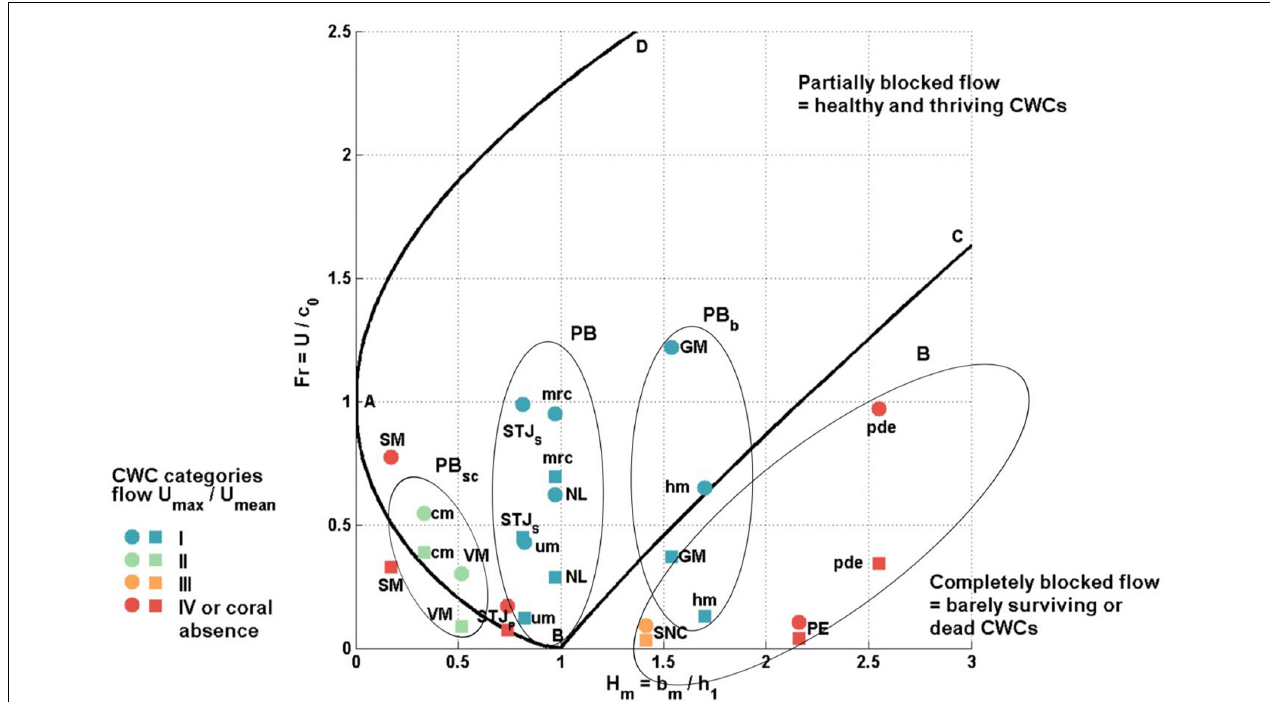
FIGURE 9 | The two layer Froude number, topography height ratio (Fr, H m ) diagram. Mean horizontal flow velocity (square) and maximum horizontal flow velocity (circle) cases are shown. Sites used in this study (STJ S , Stjernsund CWCs; STJ P , Stjernsund reference; NL, Nordleksa; GM, Galway Mound; SNC, St. Nazaire Canyon; PE, Pagés Escarpment; VM, Valentine Mounds; SM, Sylvester Mound) are shown in capital letters. Sites from literature (hm, Haas CWC mound; um, unnamed smaller mound; mrc, Mingulay Reef complex; cm, Campeche CWC mound; pde: Pen Duick Escarpment) are written with small letters. CWC categories marked in colors (blue: I, green: II, orange: III, red: IV and CWC absence). The four CWC growth states are shown with ellipses; PB sc : Healthy category II sites with subcritical flow where flow is partially blocked during high tide, PB: Healthy category I sites with partially blocked flow, PB b : Tall and healthy CWC mounds with mostly completely blocked flow where partially blocked flow conditions are met only during the high or spring tide, B: Dead or declining sites in category III–IV with constantly blocked flow. The locations SM and STJ P are excluded from the growth states since the flow is not quasi-steady during the high tide. Flow type separation lines after (Baines, 1998).